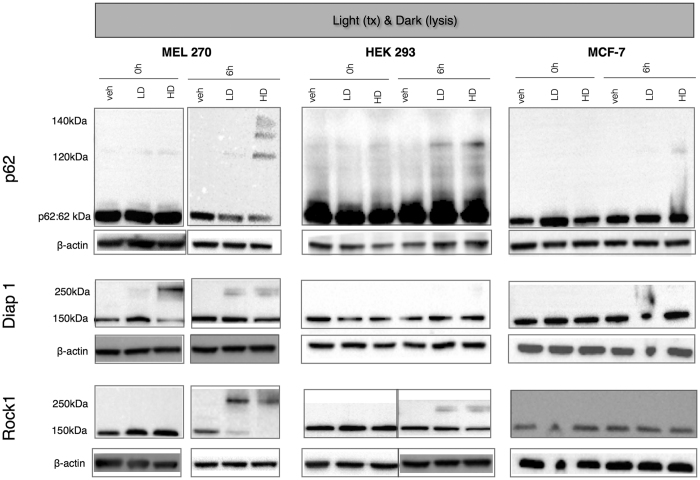
Absence of light from lysis and electrophoresis decreases the formation of protein oligomers induced by Verteporfin in MEL 270, HEK-293 and MCF-7 cell lines.Western-blot of protein extracts from cells treated in ambient light with vehicle (veh.), low dose (LD, 1.25 μg/ml) and high dose (HD, 7.5 μg/ml) of Verteporfin (VP) for 0 and 6 hours. All the subsequent steps from lysis to electrophoresis were performed in complete darkness. Absence of light from lysis and electrophoresis decreases the formation of dimers and HMWC (compare to Fig. 1).